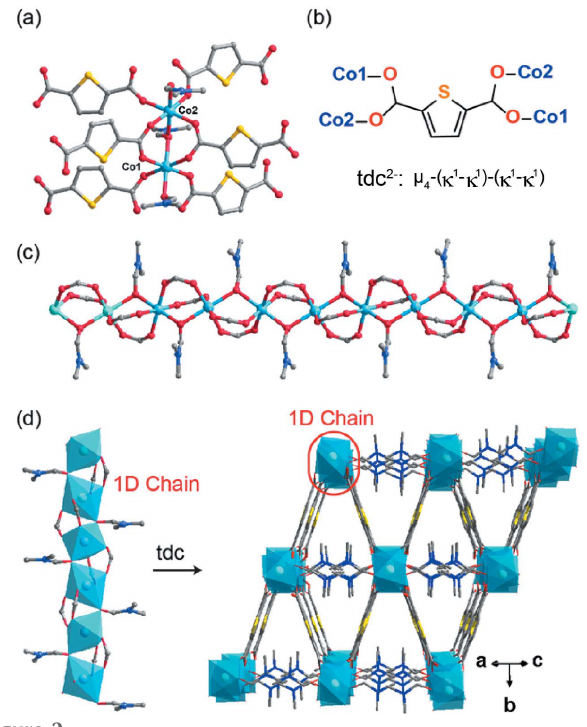
Figure 2 ( a ) Aview of the coordination environment of the Co 2+ ions. Colour code: Co 2+ , light blue; O, red; C, grey; S, yellow; N, blue. ( b ) The coordination modes of the tdc 2 (cid:2) ligand. ( c ) Structural view of the chain. ( d ) Perspective view of the three-dimensional rod–spacer framework.